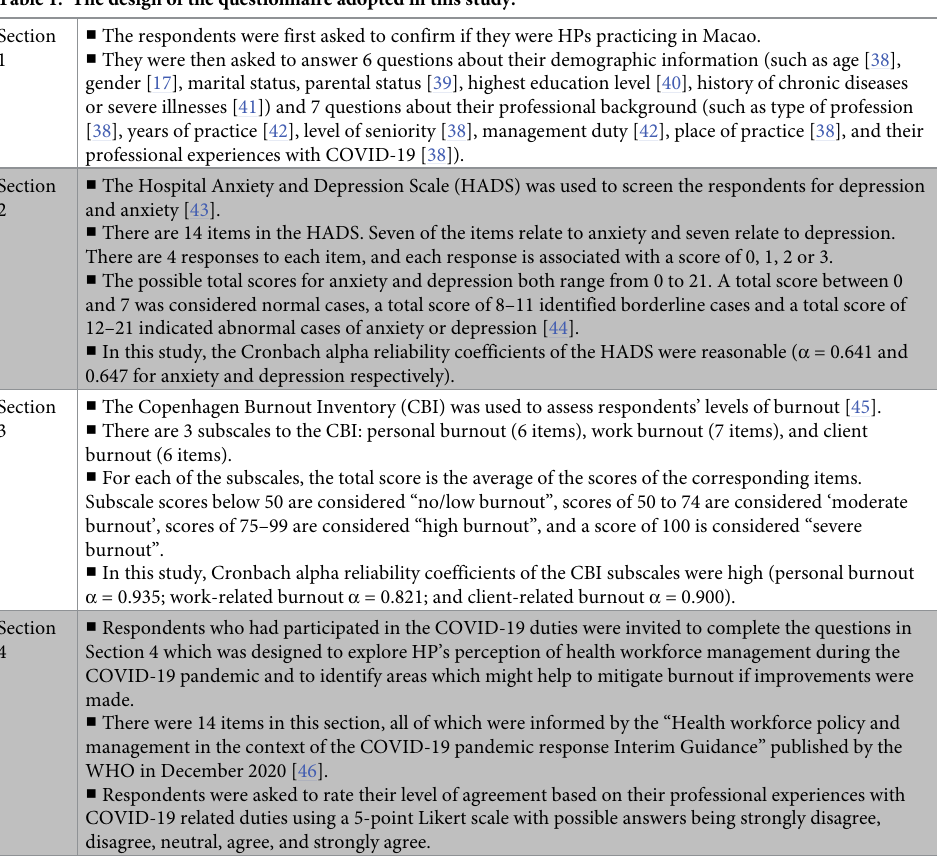
Table 1. The design of the questionnaire adopted in this